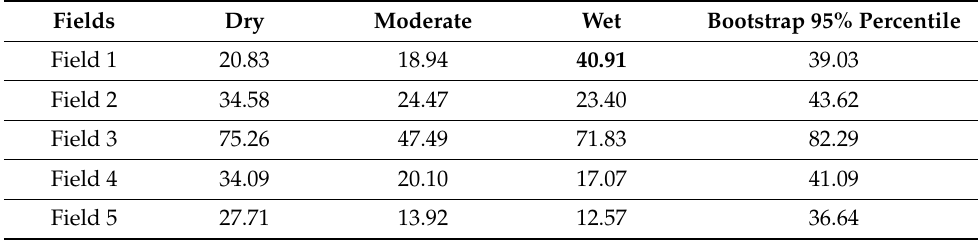
Table A2. Consistency index in different climate years based on in-crop vapor pressure deficit (ICVPD). Bold values indicate marginally significant adjusted p values ( p <